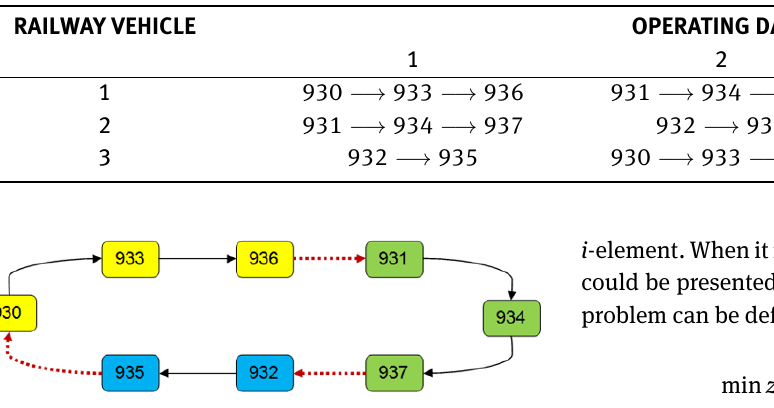
Figure 2: Graphical representation of permutation P * (source: au-